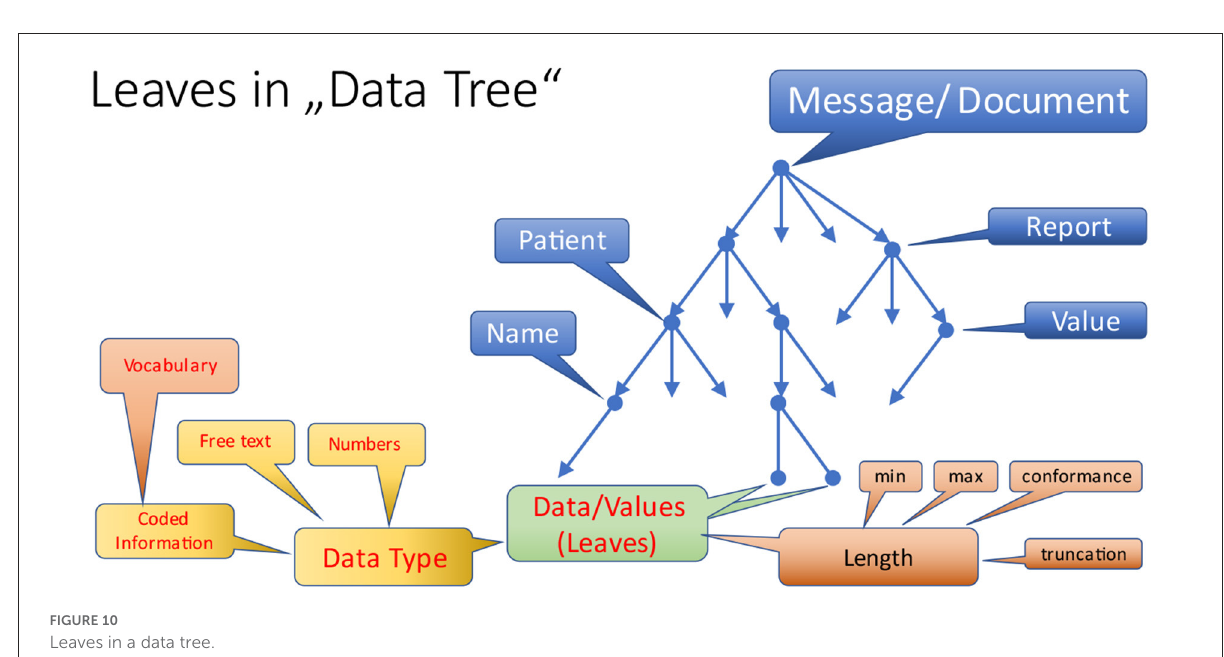
FIGURE10 Leaves in a data